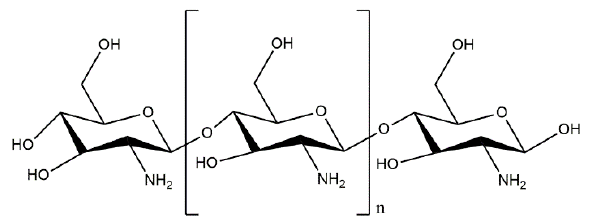
Figure 15. Schematic representation of chitosan’s chemical structure.